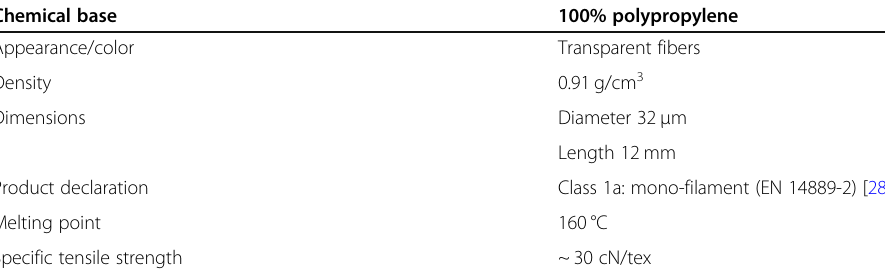
Table 2 Properties of